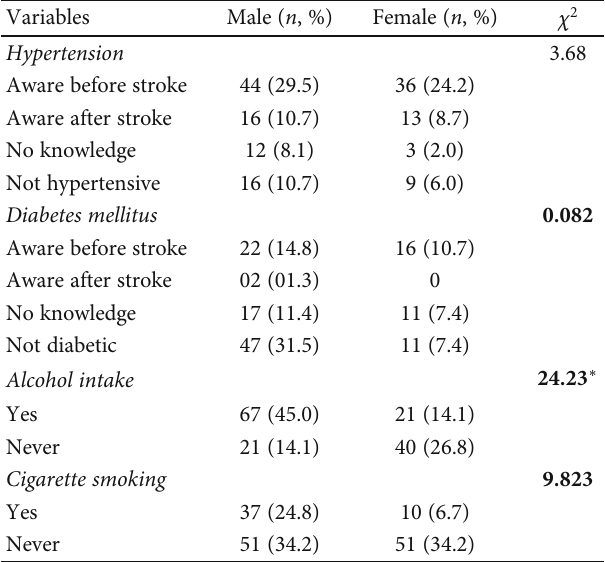
Table 2: Stroke risk factors encountered by the survivors and Pearson ’ s chi-square test of association with sex.